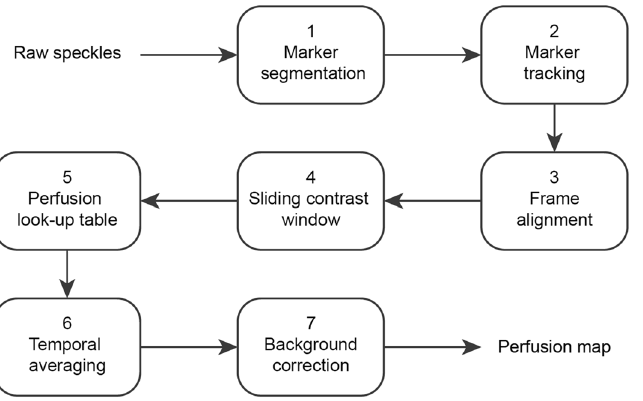
Figure 2. Analysis workflow for perfusion imaging. (1) Choosing an area within the speckle frames that includes markers and run the segmentation algorithm 26,27 . (2) Localization of segmented markers for the entire stack of frames and calculation of horizontal and vertical on-surface speed elements. (3) Translating the frames based on the computed two dimensional displacements with respect to the reference frame. (4) Applying a sliding window for local calculation of the speckle contrasts and formation of a contrast map per raw speckle frame. (5) Converting contrast maps to perfusion maps based on a pre-saved lookup table. (6) Formation of a denoised perfusion map by temporal averaging of the whole stacks of perfusion maps. (7) Making a background corrected perfusion map with normalization of the input perfusion map by the background perfusion value.